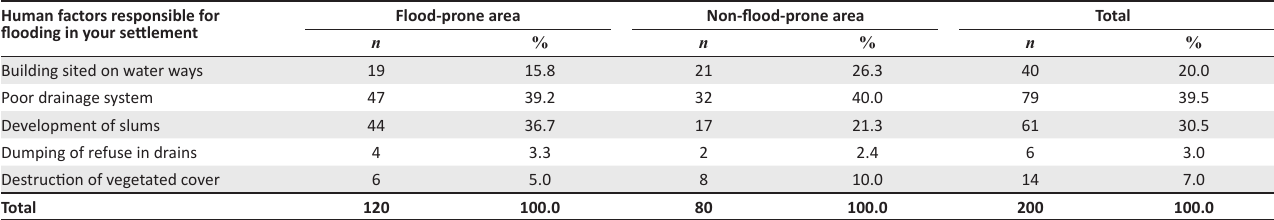
TABLE 2: Contribution of human-induced factors to